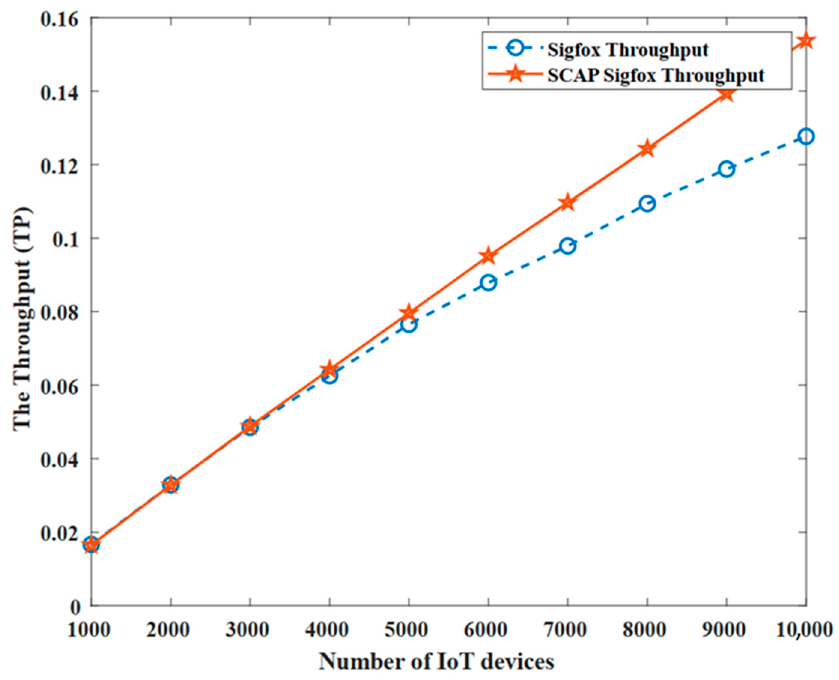
Figure 9. The throughput